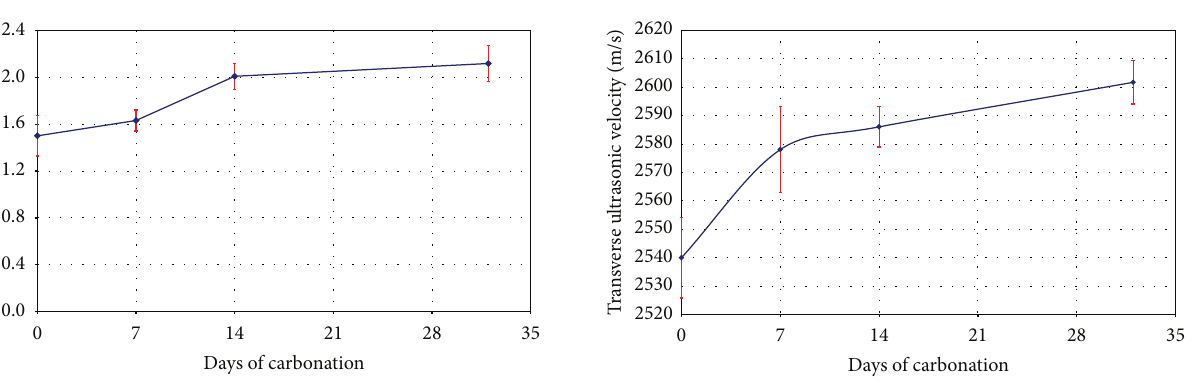
Figure 12: Evolution of the thermal diffusivity during carbonation.